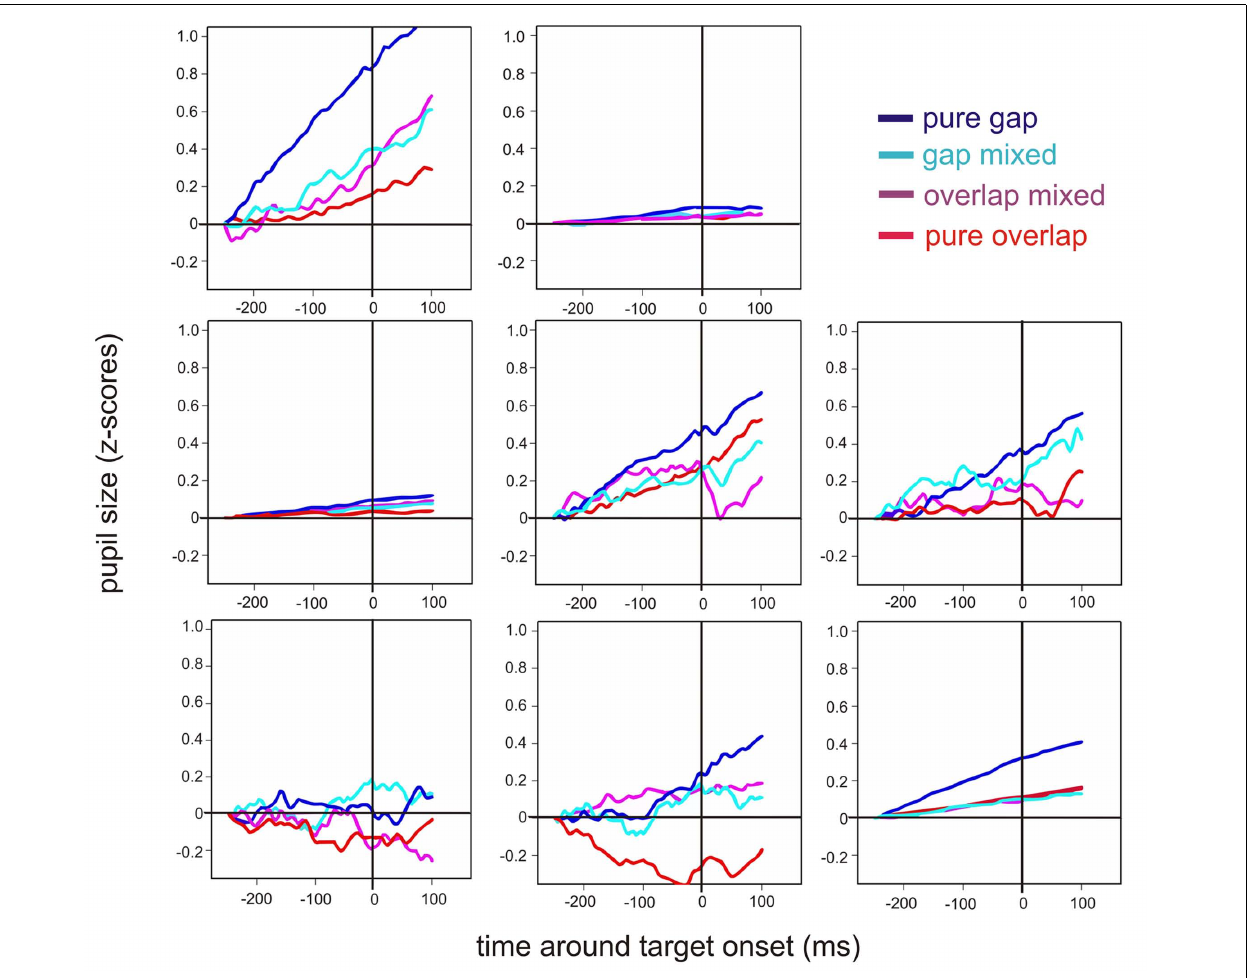
includes the 50-ms after the end of the baseline period [ − 300 − 250] to give an idea of the starting level, the gap period [ − 200 0], i.e., a time window up to target onset, and the first 100ms after the target for the saccade was already presented.The latter period reflected half of the overlap time